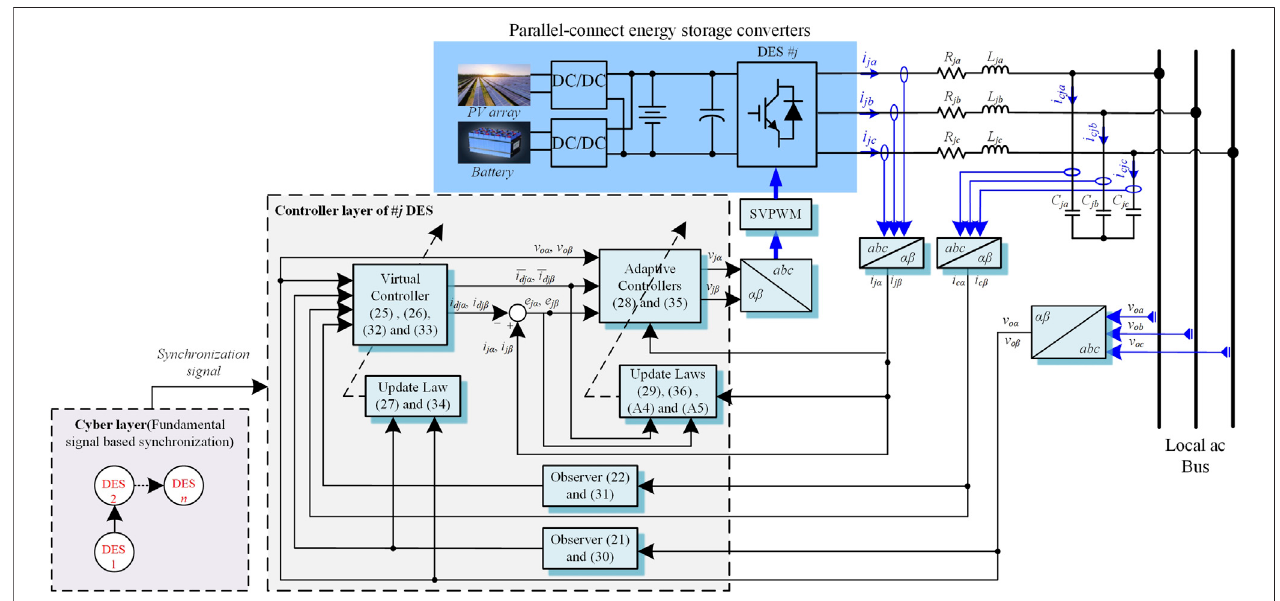
FIGURE 4 | Control block diagram of a DES module.